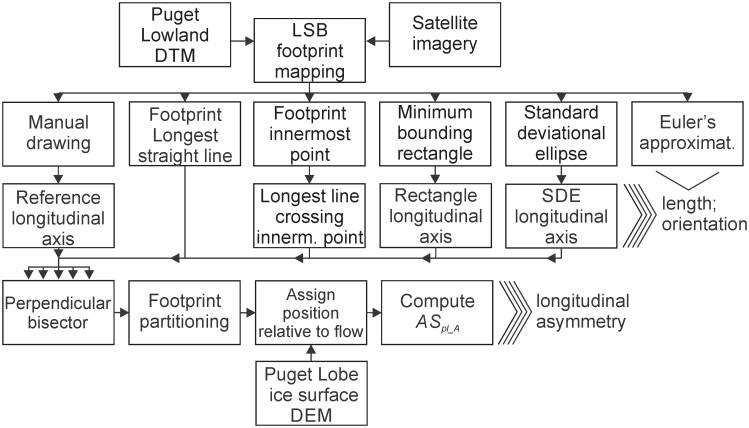
Derivation of the morphometric database for method evaluation.LSB = longitudinal subglacial bedform; DTM = digital terrain model; SDE = standard deviational ellipse; DEM = digital elevation model; ASpl_A: the ratio between the footprints’ upflow area and total area [11]. With the exception of the longest straight line (derived in Geospatial Modelling Environment® [21]), all steps were conducted in ArcMap® 10.2.